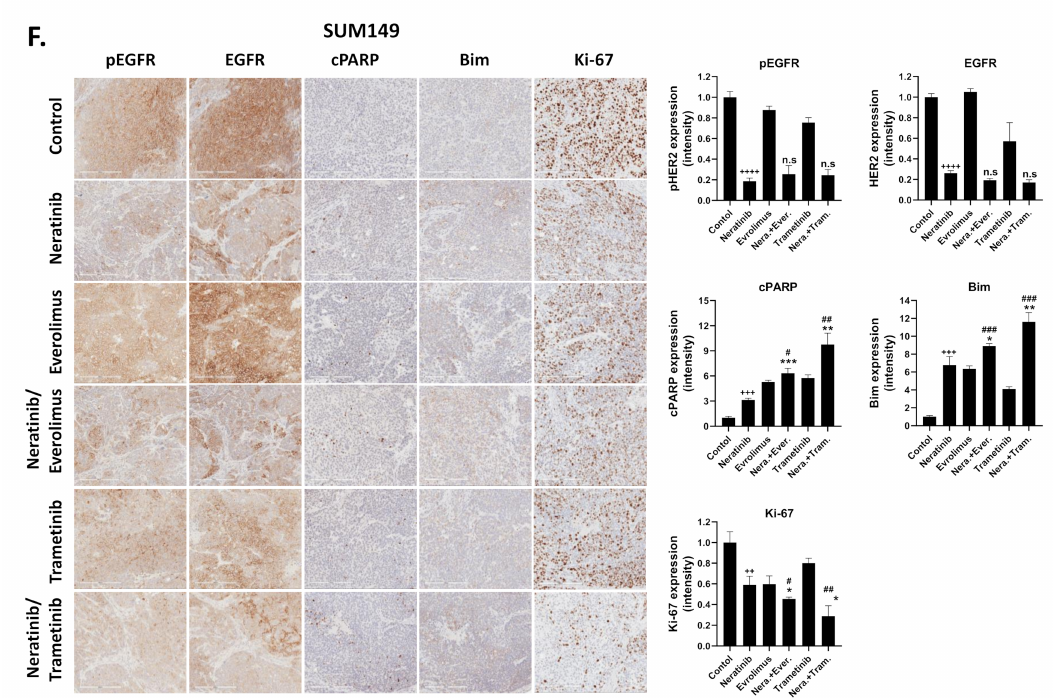
Figure 5. Everolimus or trametinib enhanced the anti-tumor effect of neratinib in both TNBC and HER2+ breast cancer cell line xenograft models. Mice were treated with neratinib (20 mg/kg), trametinib (2.5 mg/kg), everolimus (5 mg/kg), or a combination of two of the three daily by oral gavage (on a five day on and two day off schedule). ( A , B ). SUM190 (HER2+) xenograft model. ( C , D ). SUM149 (TNBC) xenograft model. The mice were treated with the indicated drugs for 22 days in the SUM190 xenograft model or 28 days in the SUM149 xenograft model. Each dot shows mean ± s.e.m. (10 mice/group). **** p < 0.0001. ( E ). IHC images of expression levels of pHER2, HER2, cPARP, Bim, and Ki-67 in SUM190 xenograft tumors tissues. ( F ). IHC images of expression levels of pEGFR, EGFR, cPARP, Bim, and Ki-67 in SUM149 xenograft tumors tissues. Data shown are representative of three IHC staining experiments from each treatment group with similar results. 20 × magnification. Scale bars, 200 µ m. Each box shows mean ± s.d. n.s., not significant; ++ p < 0.01, +++ p < 0.001, ++++ p < 0.0001 for control vs. neratinib; * p < 0.05, ** p < 0.01, *** p < 0.001, **** p < 0.0001 for neratinib alone vs. combination with everolimus or trametinib; # p < 0.05, ## p < 0.01, ### p < 0.001, #### p < 0.0001 for everolimus or trametinib alone vs. combination with neratinib by unpaired t